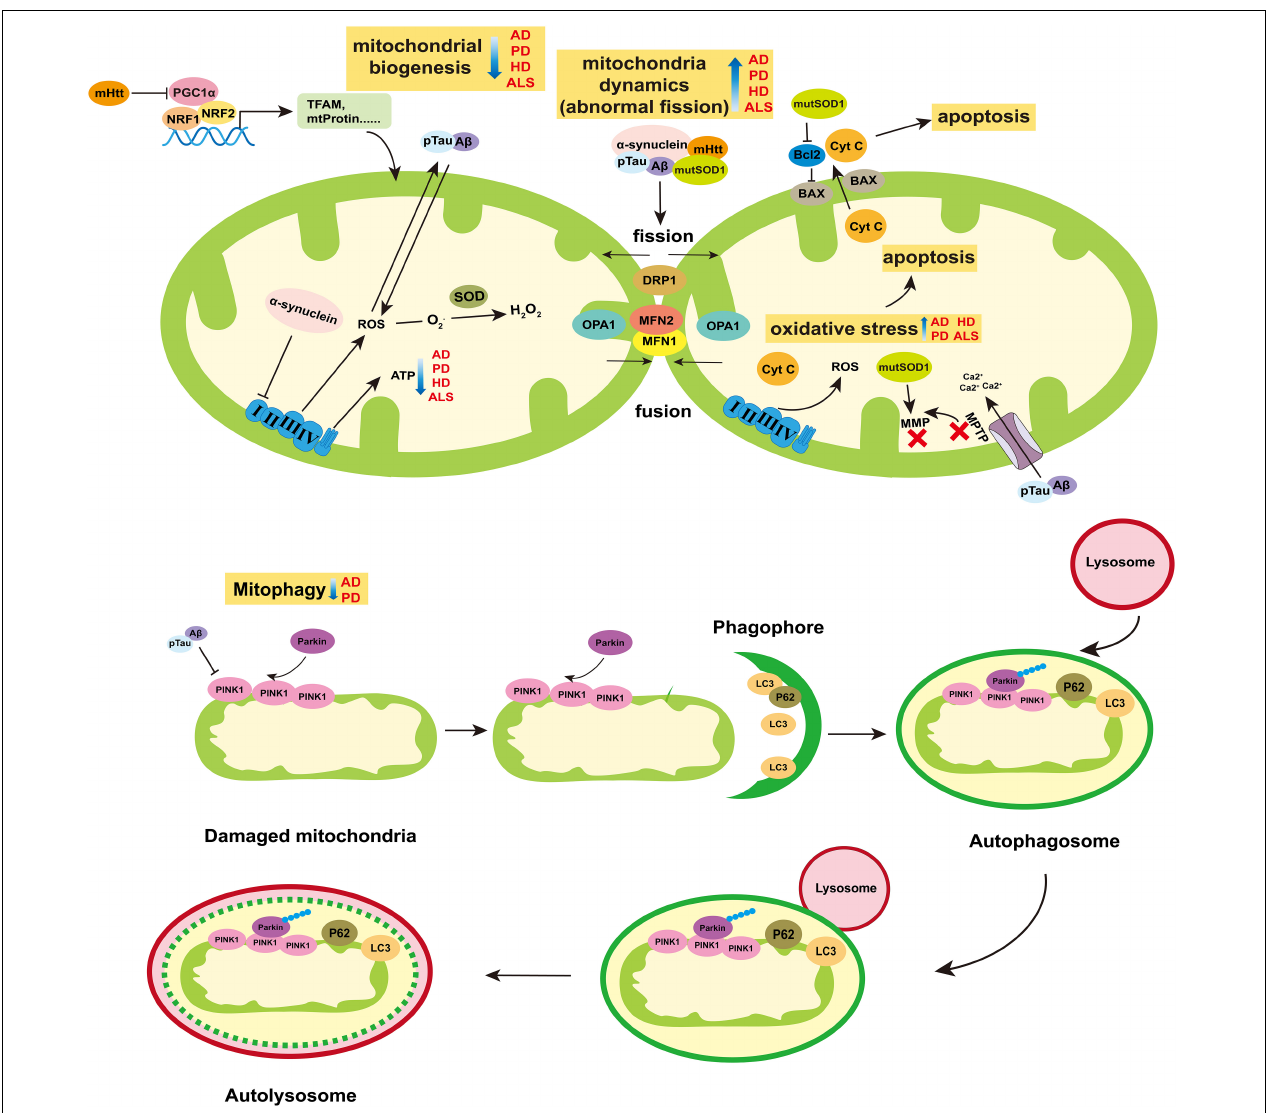
FIGURE 2 | Role of mitochondria in neurodegenerative diseases. The breakdown of mitochondrial homeostasis is considered to play crucial role in the pathogenesis of neurodegenerative diseases. Mitochondrial biogenesis, dynamics, mitophagy, and ROS-mediated cell apoptosis are ways for mitochondria to maintain homeostasis. The ability of mitochondrial biogenesis is reduced in AD, PD, HD, and ALS. Particularly, the mHtt can suppress the activity of PGC1 α , which is the main cause of mitochondria dysfunction in HD. Abnormal mitochondrial division appear in AD, PD, HD, and ALS. The pTau and A β of AD, α -synuclein of PD, mHtt of HD and mutSOD of ALS can increase the protein levels of mitochondria fission (DRP1), and reduce mitochondria fusion (MFN1/2 and OPA1). The release of ROS increases in those four diseases, which can induce oxidative stress and then mediate cell apoptosis. In AD and PD, mitophagy is blocked, which prevents the damaged mitochondria from being removed effectively. Moreover, α -synuclein can inhibit the activity of complex I of ETC. pTau and A β can enlarge the MPTP to decrease the MMP, which can reduce the synthesis of ATP. Besides, the mutSOD can destroy the MMP and have impair on mitochondria functions. Abbreviations: AD, Alzheimer’s disease; PD, Parkinson’s disease; HD, Huntington’s disease; ALS, amyotrophic lateral sclerosis; A β , β -Amyloid protein; pTau, phosphorylated Tau; mHtt, mutation Htt protein; mutSOD, mutation SOD protein; MMP, mitochondrial membrane potential; and MPTP, Mitochondrial Permeability Transition